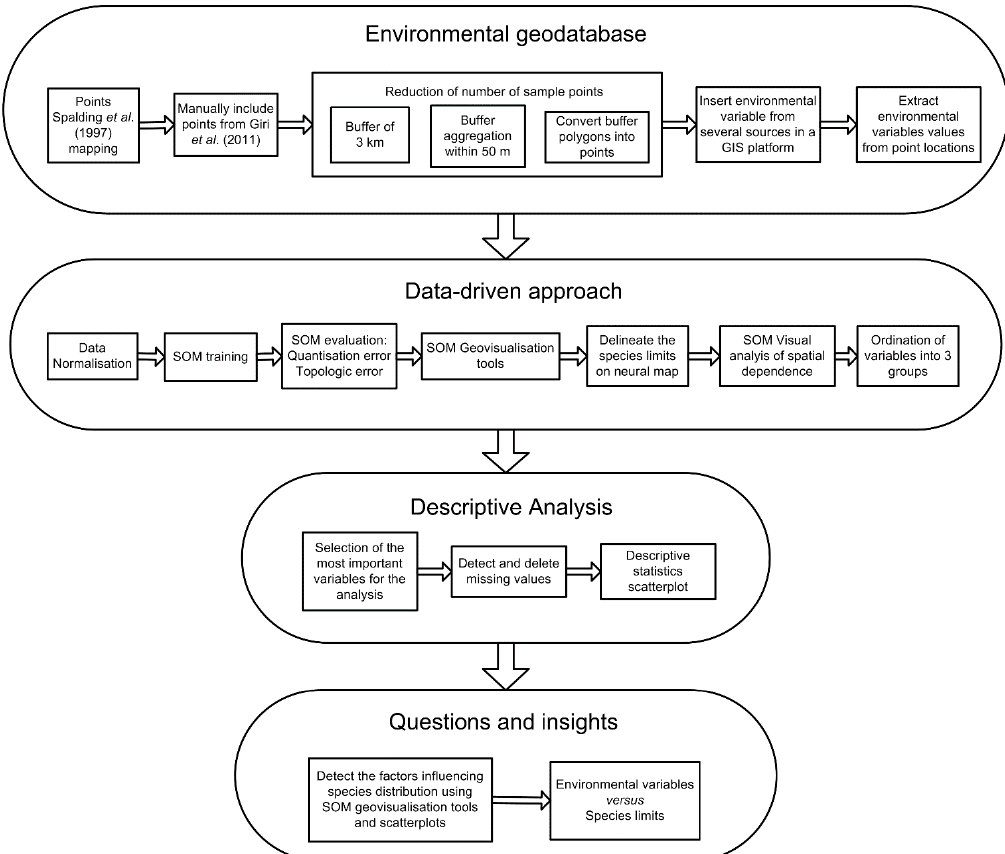
Figure 2. Methodological framework. Framework of the methodology applied in this study following four main steps. We refer to the text for methodological details.